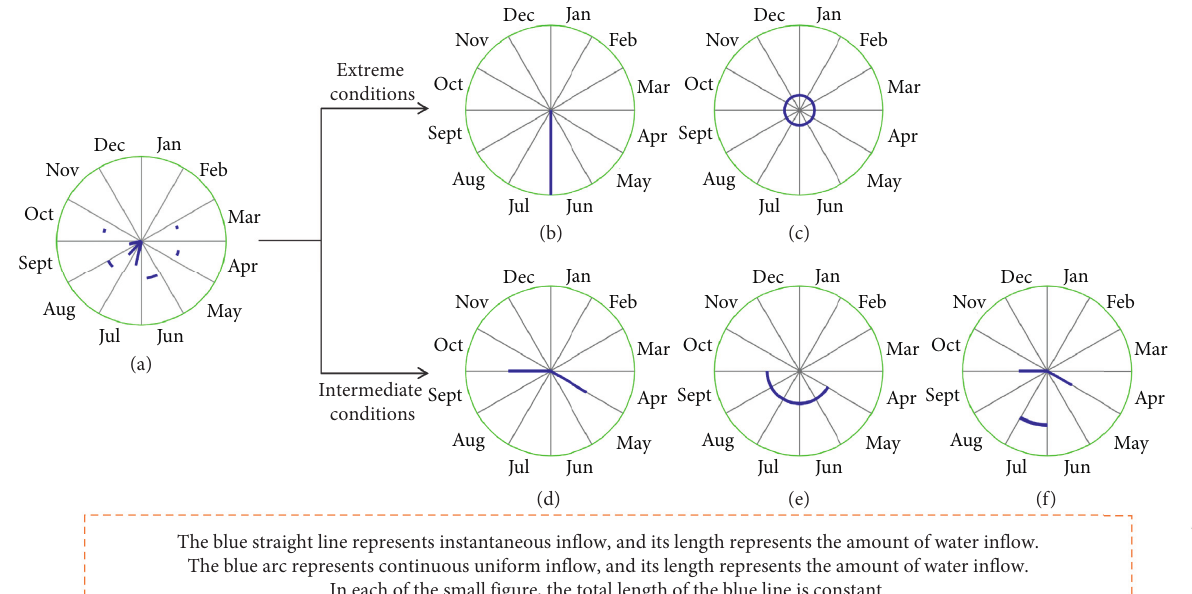
Figure 5: (a) Mode of reservoir water replenishment and loss; (b) an instantaneous inflow in extreme conditions; (c) continuous inflow in extreme conditions; (d) two instantaneous inflows in intermediate conditions; (e) one continuous inflow in intermediate conditions; (f) mixed inflow in intermediate